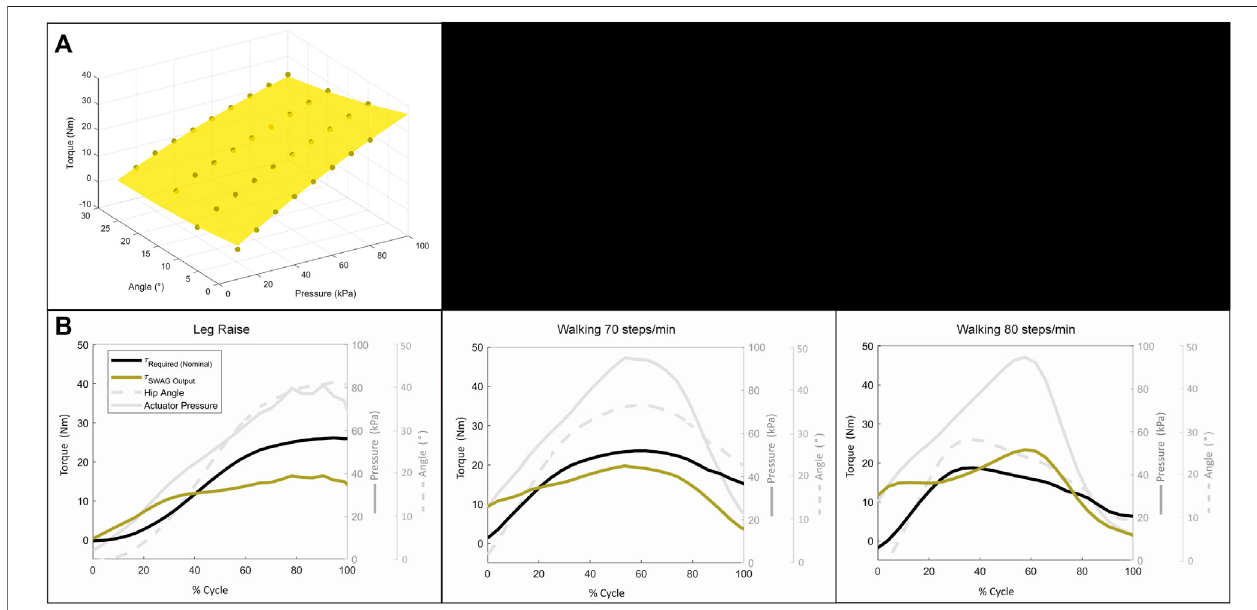
FIGURE 11 | Dynamic torque assessment: (A) Surface fi t for estimation of device torque output. (B) Results of dynamic torque assessment.